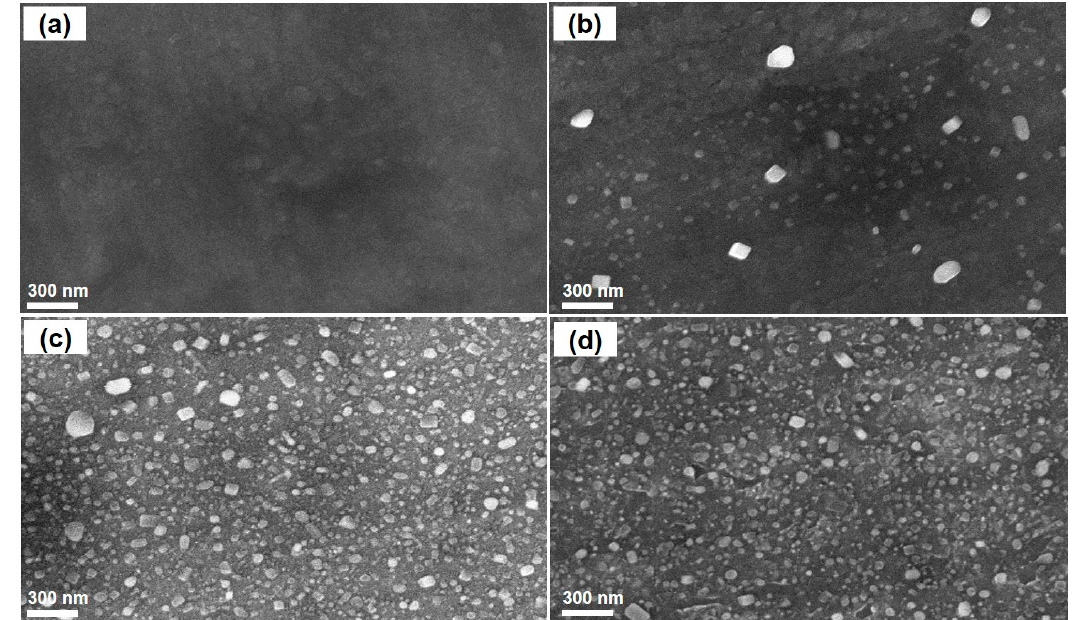
Figure 5. SEM images of the stainless-steel foil ( a ) and after pretreatment at different temperatures for 10 min: ( b ) 750 °C; ( c ) 850 °C; ( d ) 950 °C.